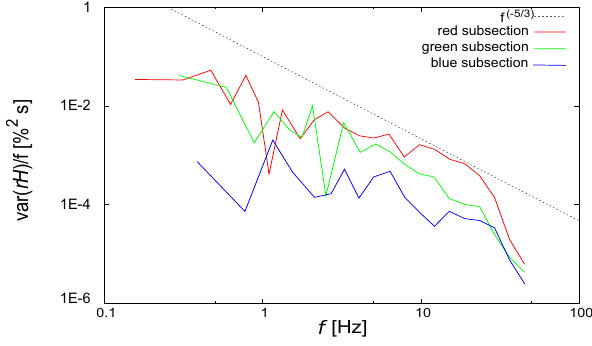
Fig. 8. Power spectral density of three different subsections (green, blue and red lines) during cloud penetration of ACTOS at cloud base. Dashed line refers to the − 5 / 3 slope for the inertial subrange